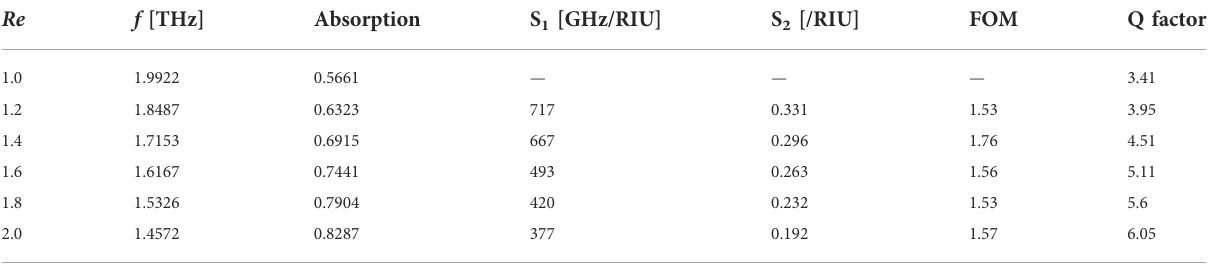
TABLE 2 Q, FOM, S 1 , S 2 when the resonant peak M2 changes with Re at h 2 (cid:1) 130 μ m.